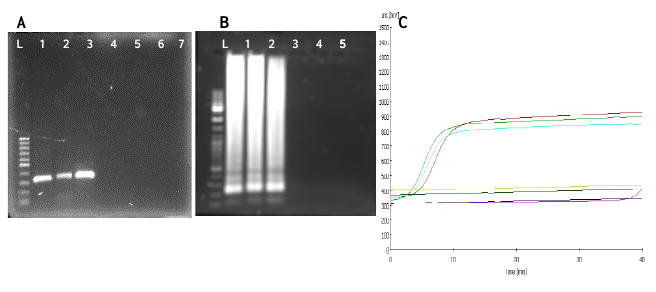
Figure 3: Specificity of one-step RT-PCR (A) and RT-LAMP (B). (Left to right) (A) Lane L shows 100bp DNA ladder (VC 100bp Plus Vivantis®), lane 1, 2, 3, shows amplification for FMDV genome while lane 4, 5, 6 and 7 depicts no amplification for PPRV, IBDV, NDV and negative control respectively by RT-PCR. (B)) Lane L shows 100bp DNA ladder (VC 100bp Plus Vivantis®), lane 1, 2, 3, shows amplification for FMDV genome while lane 4, 5, 6 and 7 depicts no amplification for PPRV, IBDV, NDV and negative control respectively by RT-LAMP. (C)Amplification curves obtained using the ESE-Quant tube scanner with fluorescence in mV plotted against time in min are shown, negative control and 10-6 dilution of RNA shows no amplification while RNA of FMDV from 1 to 10-5 dilutions showed